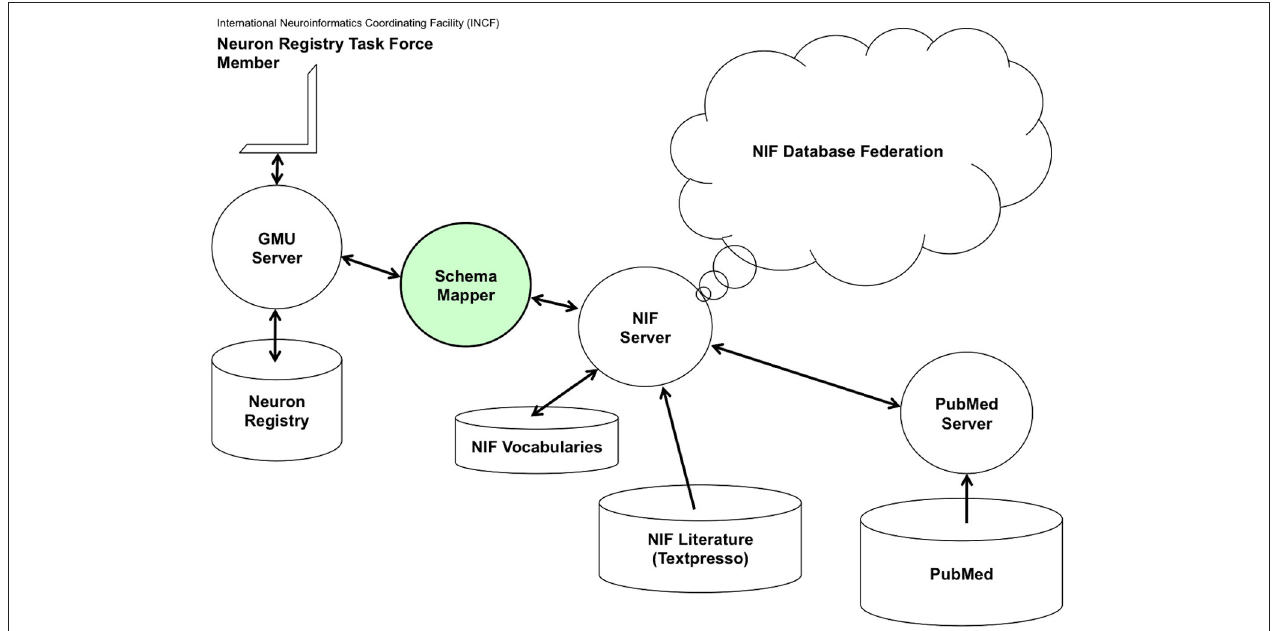
FIGURE 3 | Neuron Registry NIF Interface—This is a concept diagram depicting a planned capability not yet realized at the time of this writing.